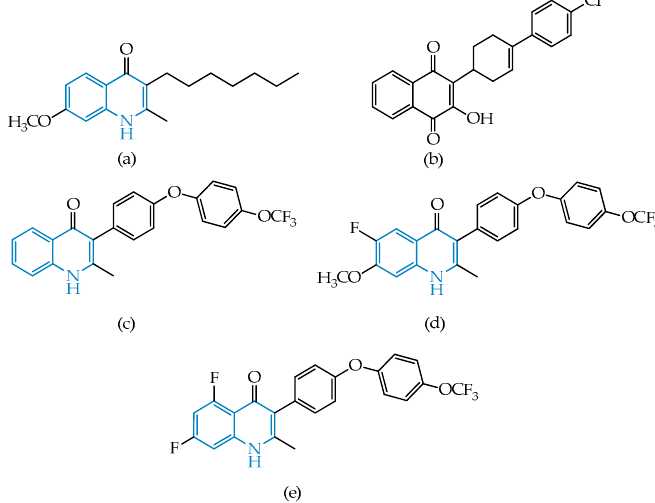
Figure 1. Structural representation of endochin ( a ), atovaquone ( b ), and candidates ELQ-271 ( c ), ELQ-316 ( d ) and ELQ-400 ( e ).